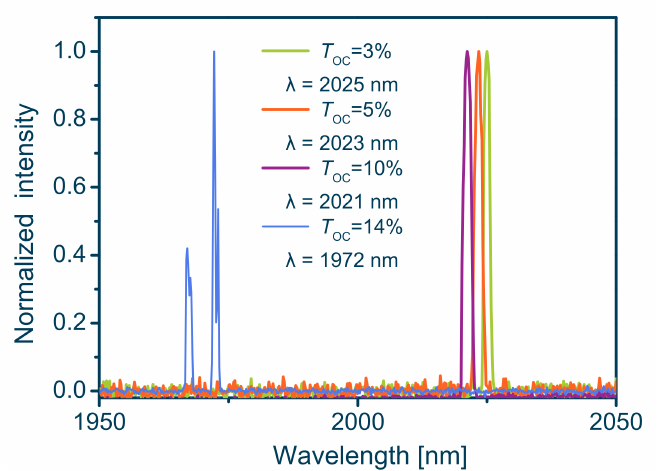
Figure 5. The laser spectrum of Tm:LuAG SCF with different